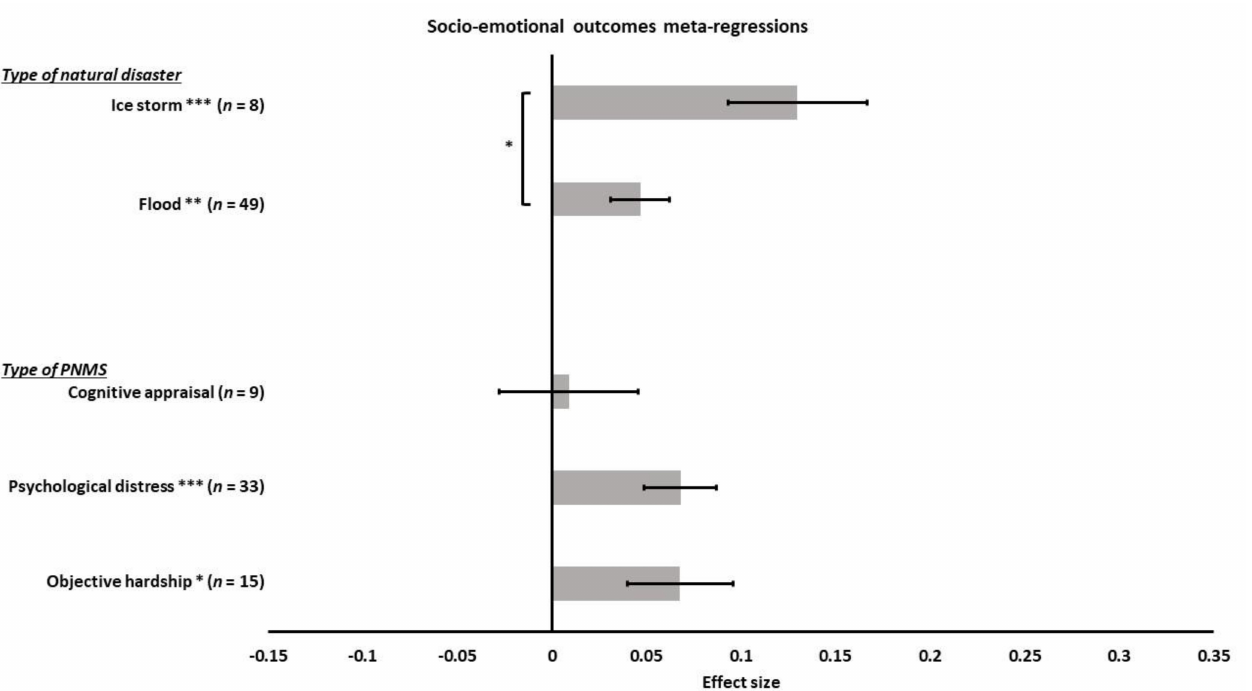
Figure 16. Socio-emotional outcomes meta-regressions. Type of PNMS effect (objective hardship; psychological distress; cognitive appraisal) on socio-emotional outcomes and type of natural disaster (flood; ice storm) on the association between PNMS levels and physical outcomes. Note: * p < 0.05; ** p < 0.01; *** p <